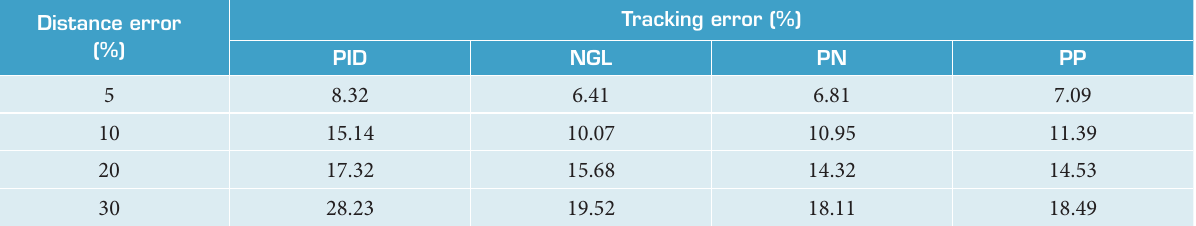
Table 2. Tracking error due to the distance error.